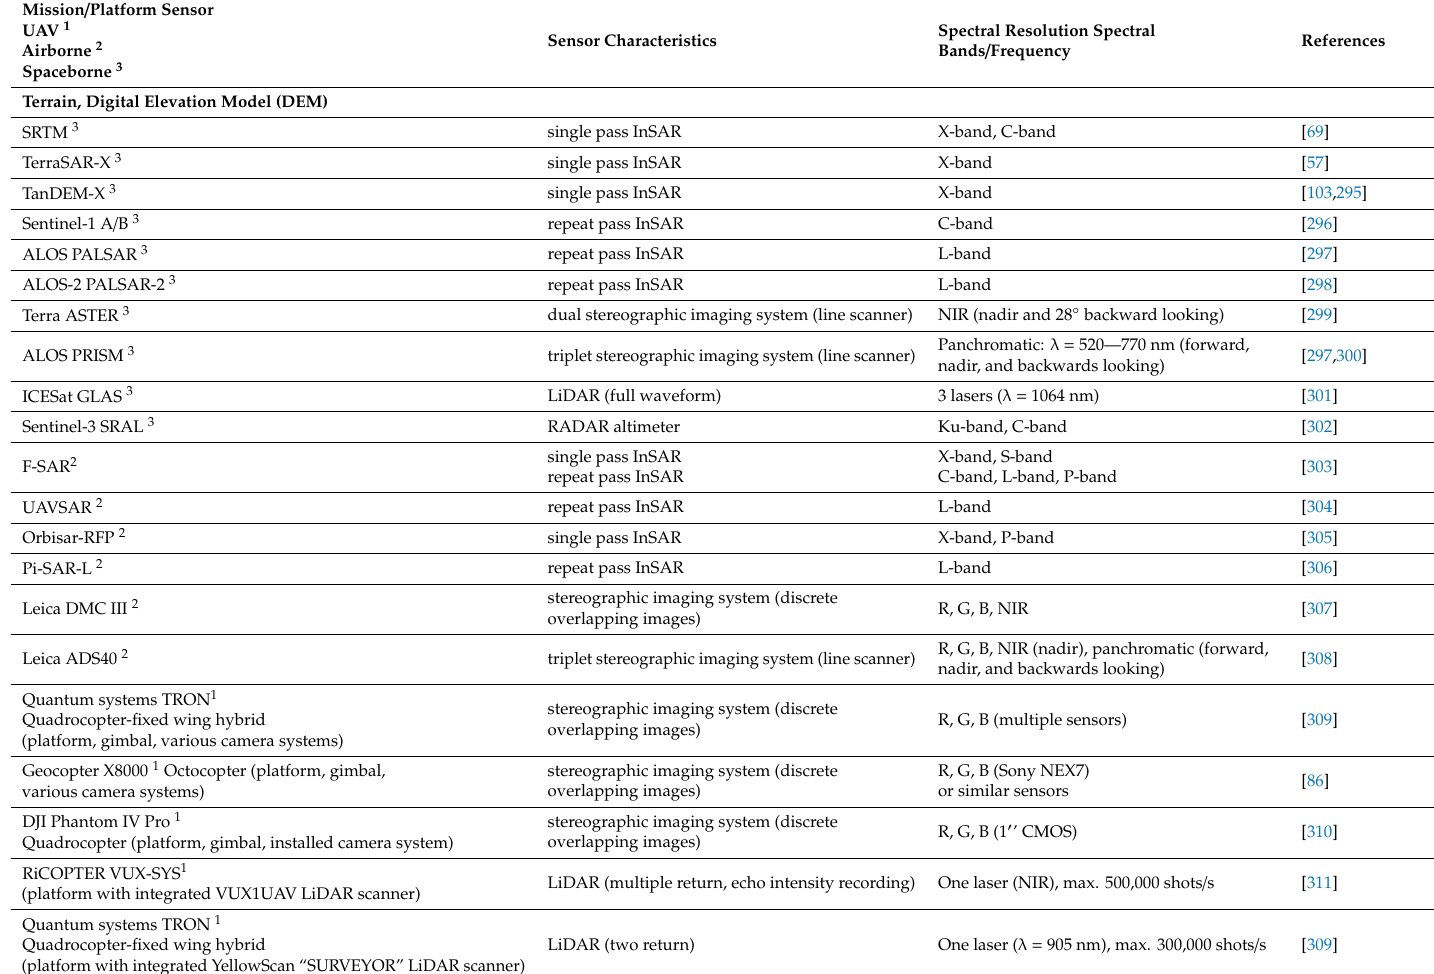
Table 4. RS-assisted derivation of terrain and landscape